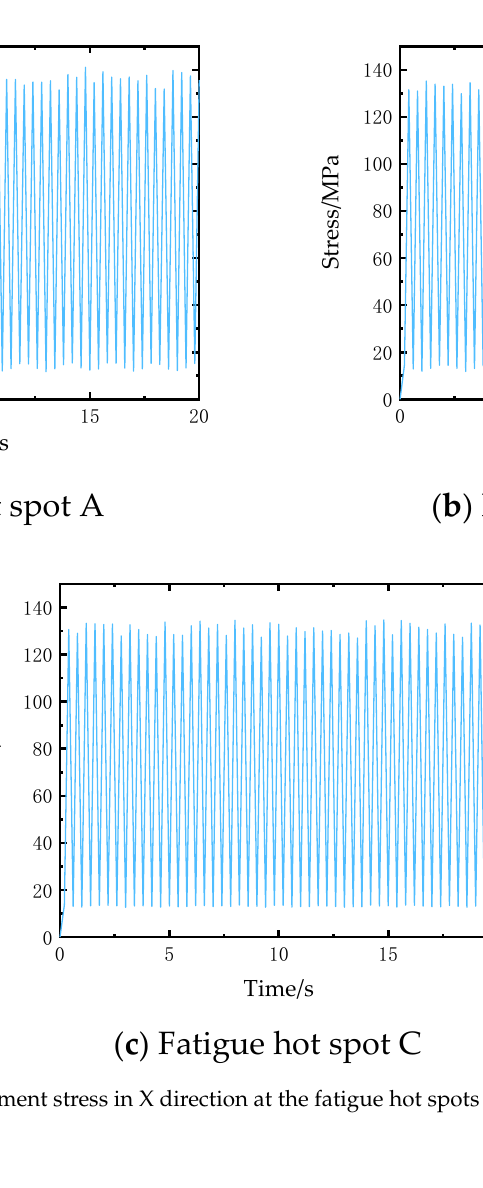
Figure 11. Sub-model at the center in macroscopical element. The 2D SiC/SiC mesoscopic single cell model was analyzed by finite element method after boundary conditions were applied. According to Saint-Venant principle, the influ- ence of boundary conditions can be ignored in the region far away from boundary con- straints. According to the analysis in Section 3.1, the maximum stress in 2D SiC/SiC meso- model yarn under tensile load occurs in the yarn-to-yarn lap area, far away from the boundary point. Therefore, the maximum stress in the yarn was selected as the fatigue peak stress in the subsequent fatigue damage analysis of the yarn. The maximum stress in X direction in the yarn is shown in Figure 12. Extract the maximum stress peak value of the schedule, yarn into 2.2 failure determi- nation process of ceramic matrix composites, and under each peak stress calculation of the fatigue life of CMCs. Then, calculate the fatigue damage of each peak stress by Miner linear fatigue damage accumulation theory. Finally, the total fatigue damage under 20 S random fatigue load was accumulated according to Equation (14), and then the fatigue life of the cross-stiffened plate was calculated according to Equation (15). The calculated